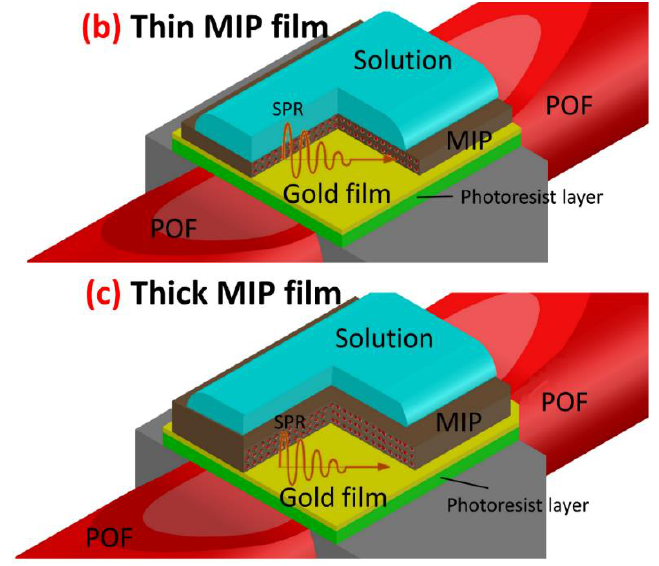
Figure 1. Optical-chemical sensor system: ( a ) outline of the experimental setup; ( b ) surface plasmon resonance- plastic optical fiber (SPR-POF) platform covered by a thin molecularly imprinted polymer (MIP) layer; ( c ) SPR-POF platform covered by a thick MIP layer. The grey block represents the resin support (1 cm × 1 cm × 1 cm) in which the POF is embedded.